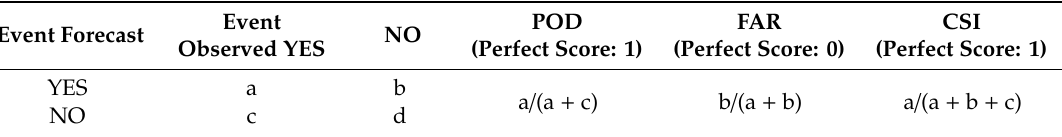
Table 3. Contingency table and statistics. The counts a, b, c and d are the total number of hits, false alarms, misses and correct